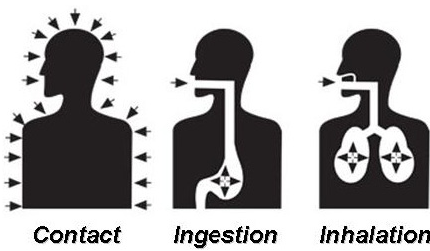
Figure 2. Main routes of pesticide entry in the human organism [8].